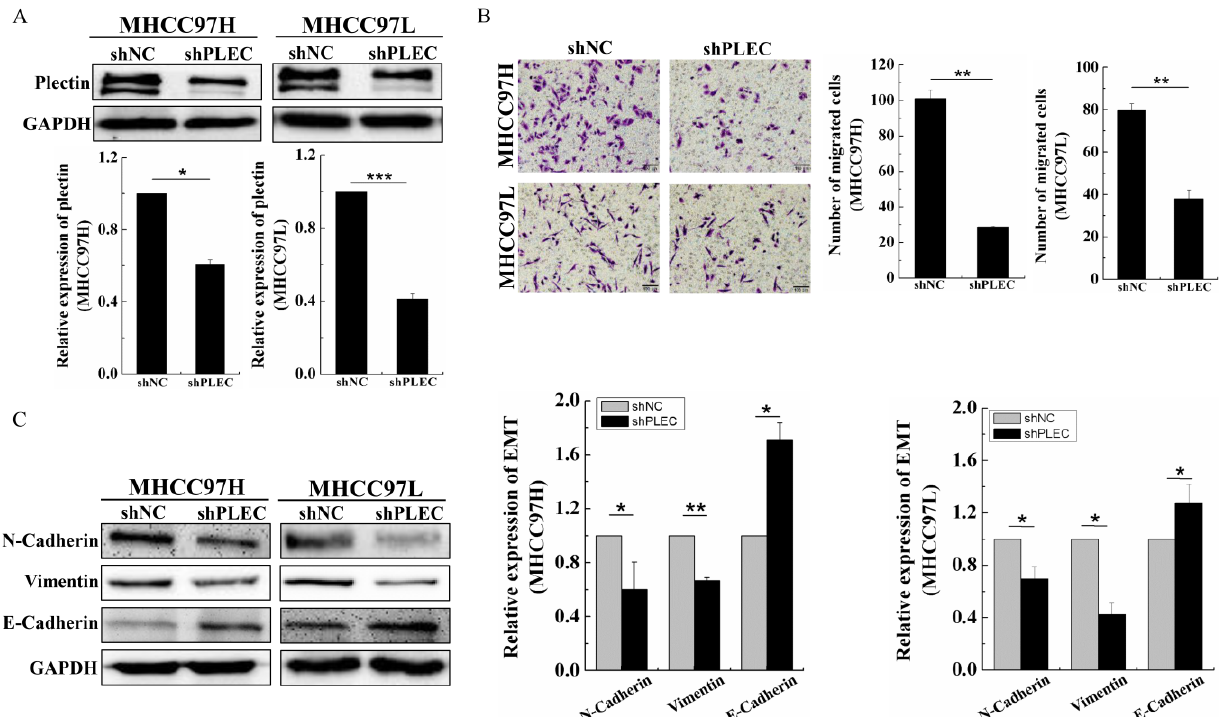
Figure 2. Plectin downregulation inhibits HCC cell migration and EMT. ( A ) Western blot detection of plectin protein level in cells transfected with the shNC and shPLEC and quantification data of Western blot detection of plectin protein level in cells transfected with the shNC and shPLEC. ( B ) Transwell assays for migration ability evaluation in cells transfected with the shNC and shPLEC. The number of cells were counted and averaged (scale bar, 100 µm). ( C ) Western blot detection of N-cadherin, vimentin and E-cadherin in cells transfected with the shNC and shPLEC and quantification data of Western blot detection of N-cadherin, vimentin and E-cadherin protein level in cells transfected with the shNC and shPLEC. GAPDH: glyceraldehyde-3-phosphate dehydrogenase. Data are presented as mean with SD; n = 3, * p < 0.05; ** p < 0.01 ; *** p < 0.001.